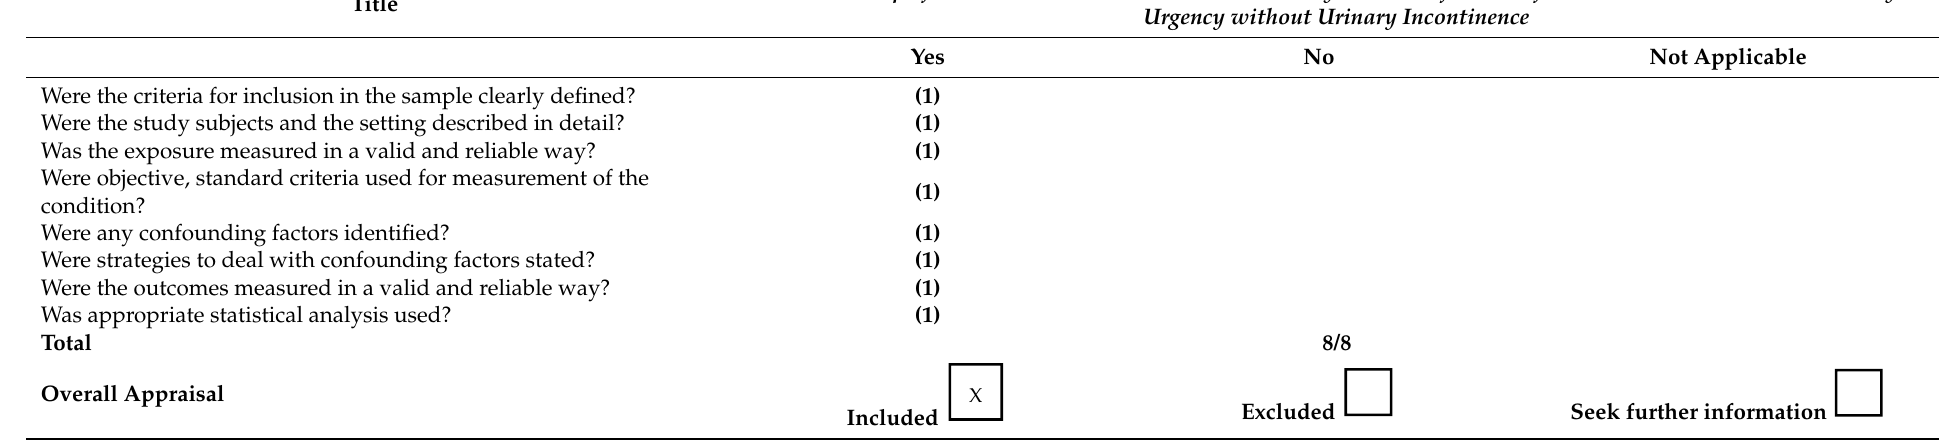
Table A3. Quality assessment for cross-sectional studies (JBI critical appraisal checklist for cross sectional studies [31]). Relationship of Bladder Pain with Clinical and Urinary Markers of Neuroinflammation in Women with Urinary